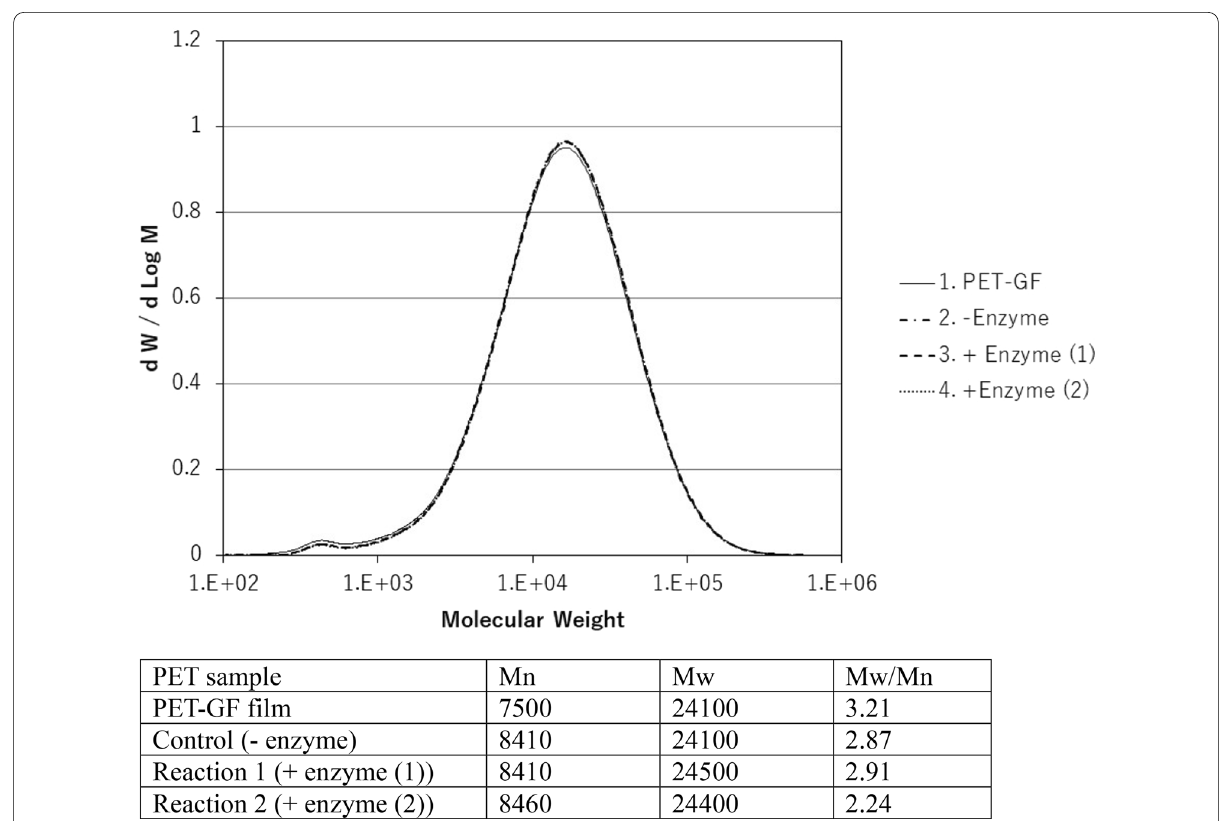
Fig. 1 Molecular weight before and after enzyamatic hydrolysis. Reactions (1 ml) were performed at 70 °C for 3 days using Cut190*SS, one piece of 6 mm PET-GF film and 100 mM HEPES buffer (pH 8.5), as described in “Materials and methods”. Degradation rates of reactions 1 and 2 were 33.6 ∅ and 31.4%, respectively. Mn: number-average molecular weight. Mw: weight-average molecular